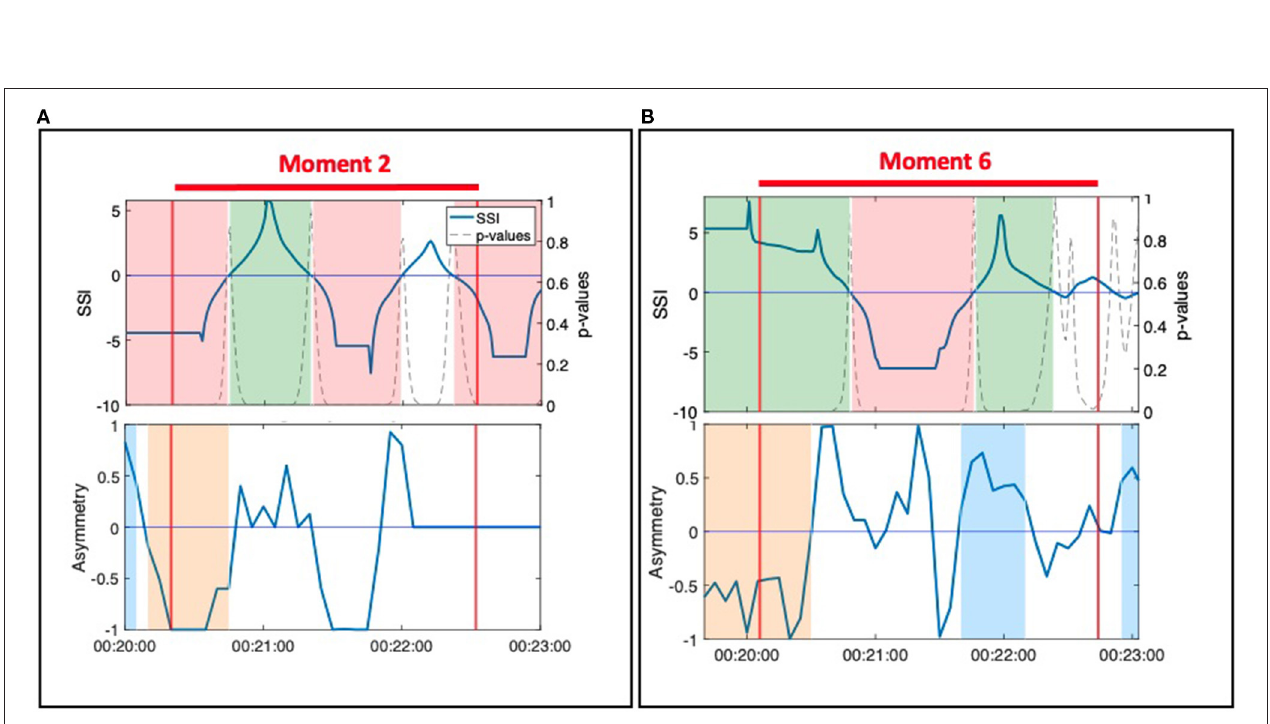
FIGURE 5 | (A) Moment 2: Hector and Jean during the resistance standing activity. (B) Moment 6: Ruth and Harvey during the resistance standing activity.